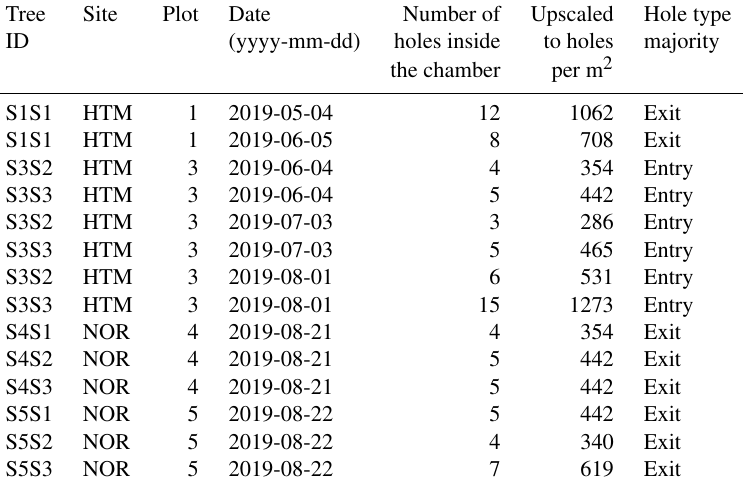
Table 2. The infested Norway spruce trees ( n = 9) by tree ID, site, plot and the number of holes counted inside the chamber at the given date of the field visit for each tree. The counted holes were upscaled to holes per square meter of bark surface, and the majority of the hole type was defined to be either mostly entry or exit holes. The bark of the Norway spruce with the ID S1S1 was infested during the late season of 2018 and thus already had a majority of exit holes early in 2019.